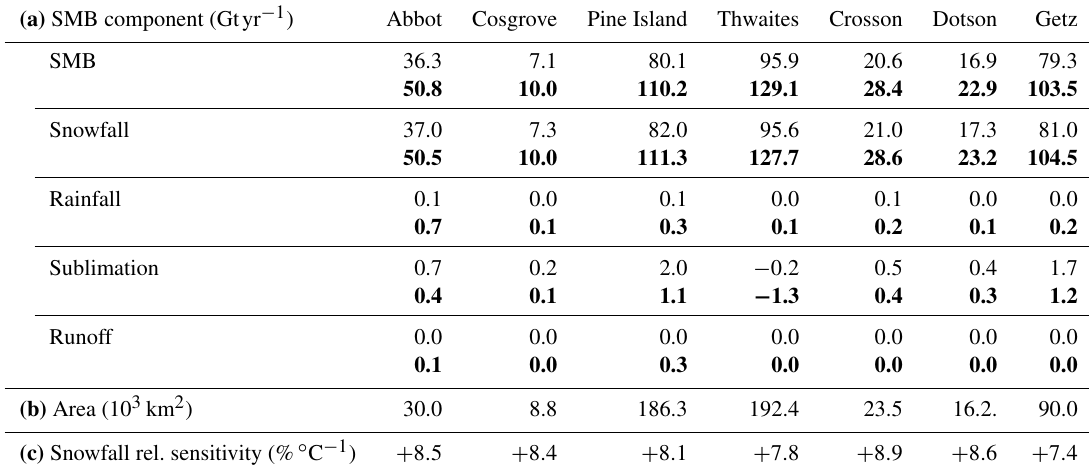
Table 1. (a) SMB and its components over the grounded part of individual glacial drainage basins for the present day (regular) and future (bold). The results are here provided in gigatons per year (Gtyr − 1 ), i.e. integrated over the drainage basins (areas indicated in b ), to be directly convertible into a rate of sea level rise. SMB is the sum of snowfall and rainfall minus sublimation and runoff. Here we assume that the net production of surface liquid water is equivalent to runoff because of the significant slopes over the coastal grounded ice sheet. (c) The relative increase in snowfall per degree of air warming at 2m above ground level (see Eq.